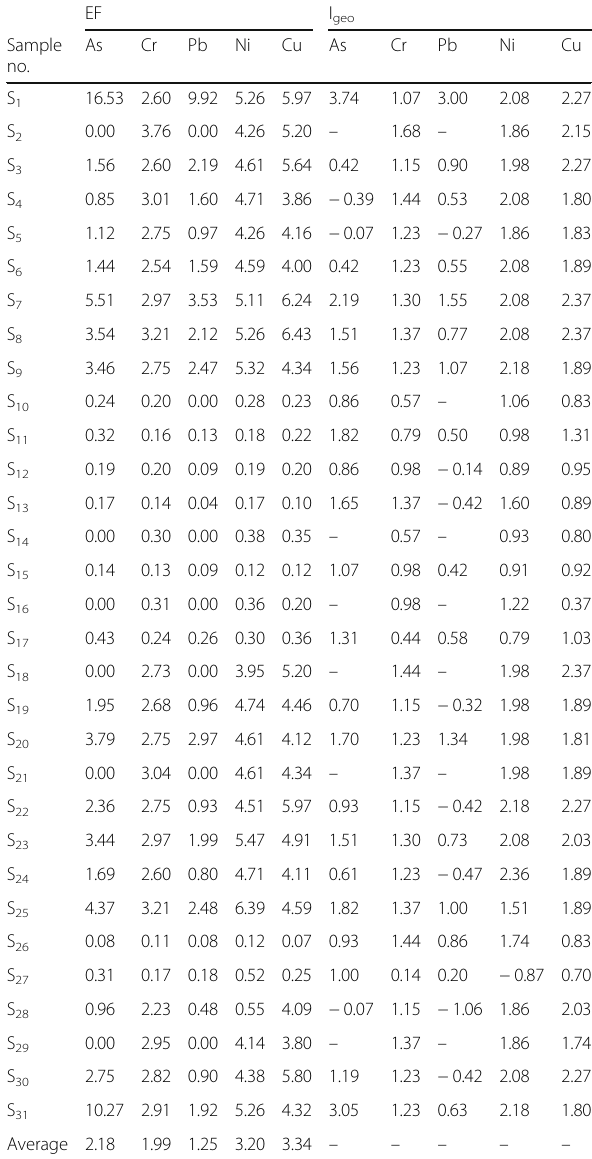
Table 3 Enrichment factor (EF) and geoaccumulation index (I geo ) of heavy metals in soil